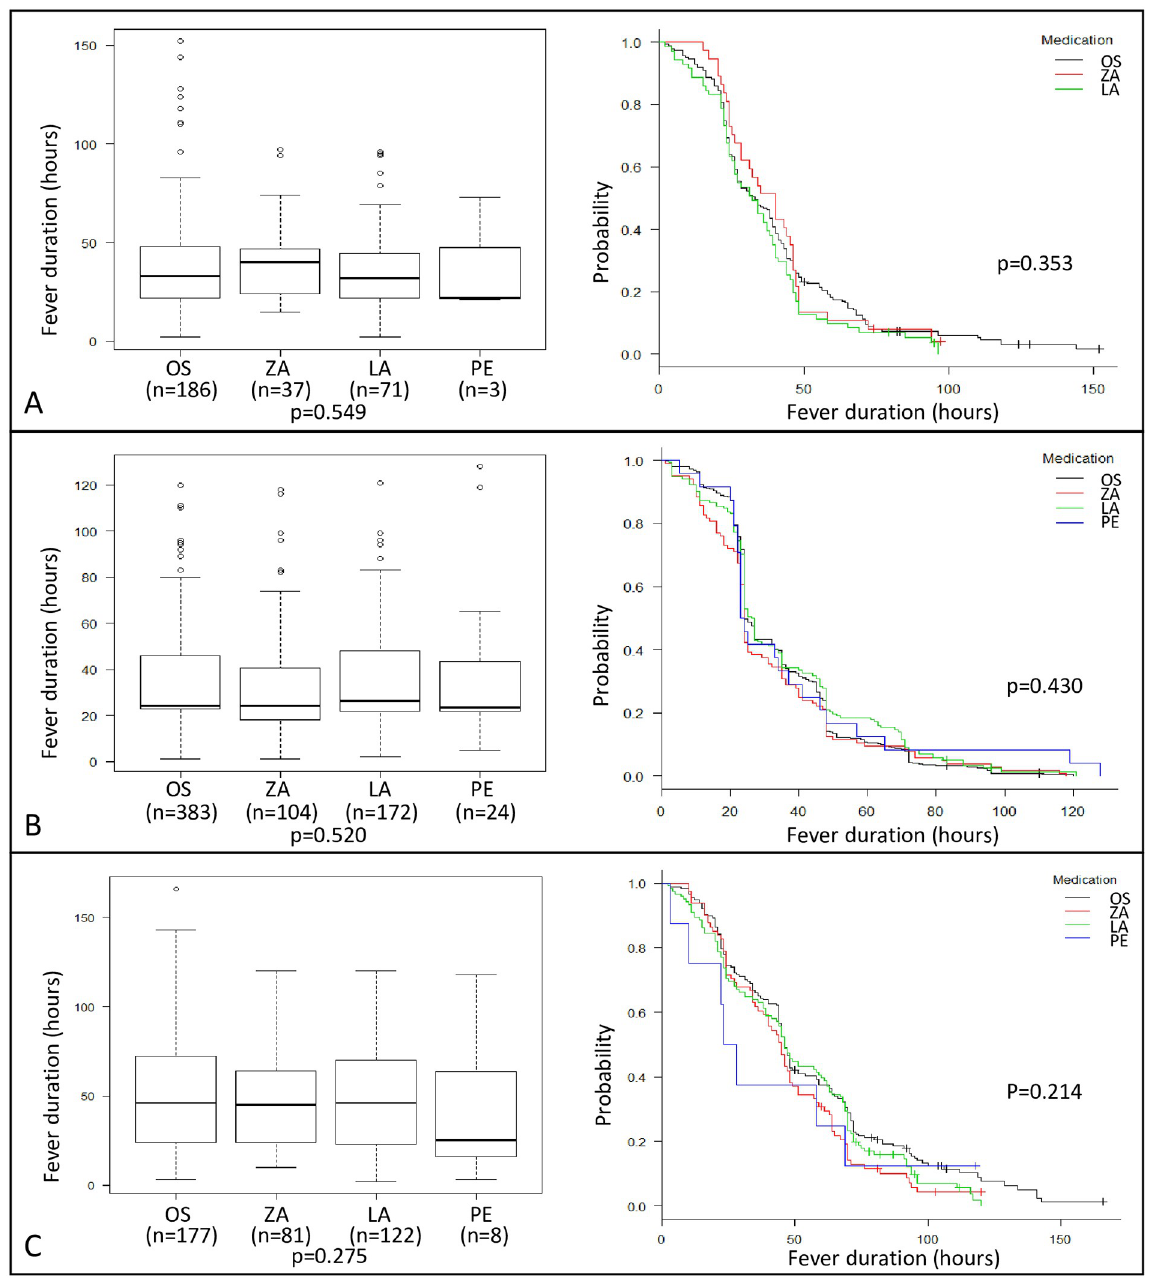
Fig 3. The comparison of fever duration by the four NAIs by type/subtype group. A: A/H1N1pdm09 group. B: A/H3N2 group. C: influenza B group. Left: Boxplots of fever duration for the four NAIs tested by ANOVA. The bold line is the average, while the box shows the interquartile range. P -value at the bottom was obtained from ANOVA. Right: Kaplan-Meyer method of fever duration. Black line: oseltamivir, red line: zanamivir, green line: laninamivir, and blue line: peramivir. P -value from log-rank analysis is indicated in the graph. The group with a sample size < 5 was excluded from analysis. OS: oseltamivir, ZA: zanamivir, LA: laninamivir, PE: peramivir, NAI: neuraminidase inhibitor.